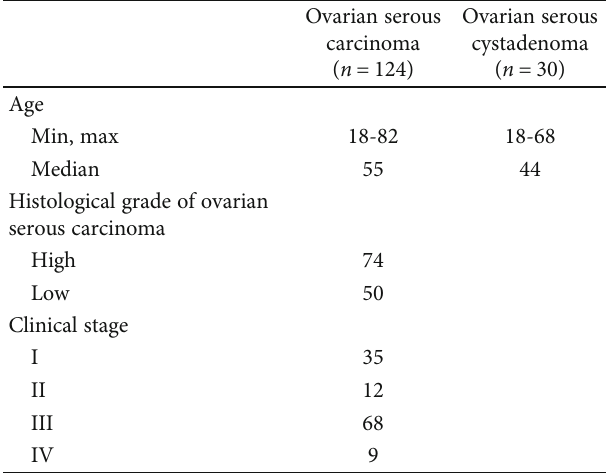
Table 1: Basic clinical information of patients with serous ovarian cancer and benign ovarian serous